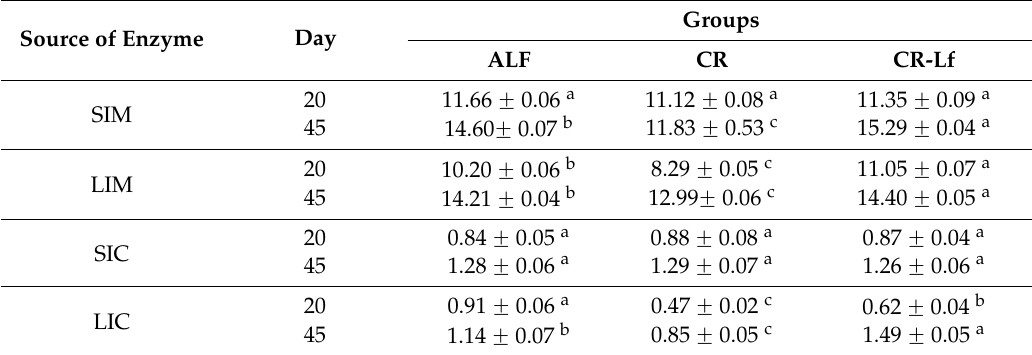
Table 1. Feruloyl esterase activity in different intestinal fractions at 20 and 45 day of feeding. Groups Source of Enzyme Day ALF CR CR-Lf 20 11.66 ˘ 0.06 SIM